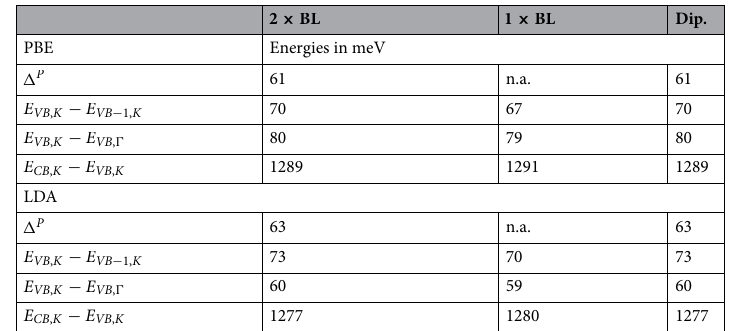
Table 1. Quantities (meV) calculated using different supercell methods for XM ′ bilayer WSe 2 —2×(1×). BL: double(single) bilayer supercell). Dip.: Dipole-corrected single bilayer supercell. (cid:31) vacuum energies, while E VB , K − E VB − 1, K , E VB , K − E VB , Ŵ , and E CB , K − E VB , K are the splitting between the top the valence bands at the K-point, the difference between the local Ŵ - and K-point valence band maxima, and the vertical K–K gap, respectively.